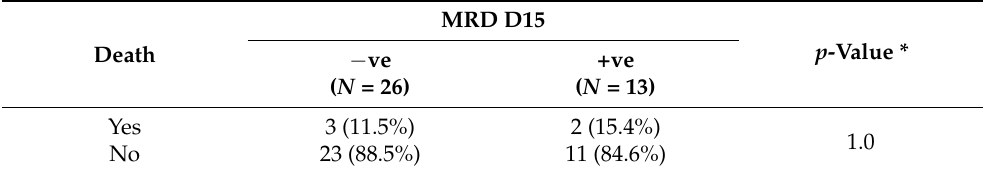
Table 7. The relationship between MRD D15 and